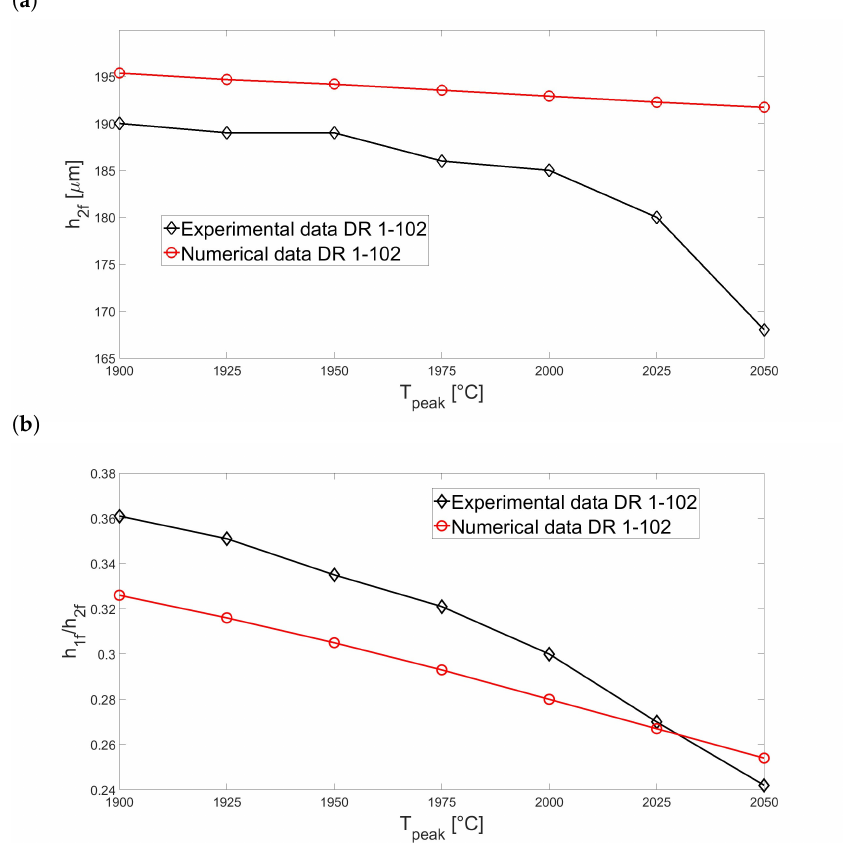
Figure 10. Comparison between the final outer diameter ( a ) and air-filling fraction ( b ) of the capillary obtained numerically and experimentally by Luzi et al. [20] for different furnace peak